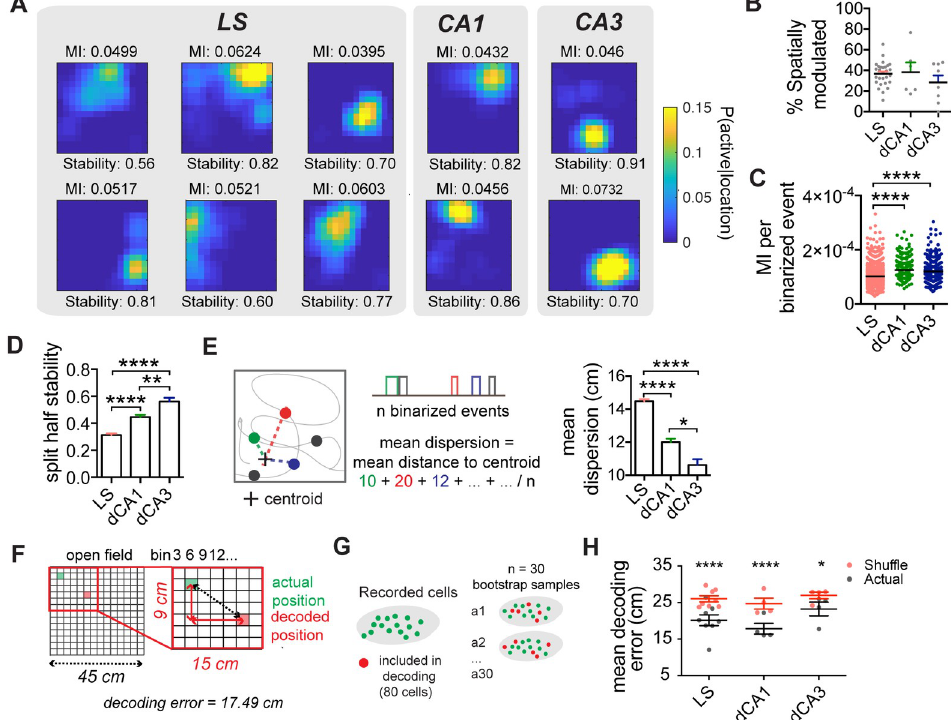
Fig 3. LS shares spatial coding characteristics with its main hippocampal inputs CA1 and CA3 during free exploration in a 2D environment. ( A) Example tuning maps of spatially modulated cells recorded from LS, dorsal CA1, and dorsal CA3 in a 45 × 45 cm open field (3 × 3 cm bins). (B) Proportion of spatial cells per animal (LS: n = 28 mice; dCA1: n = 6 mice; dCA3: n = 8 mice). (C) MI (bits) per binarized event for all cells recorded from each region (LS: n = 1,899 cells from n = 28 mice; dCA1: n = 1,031 cells, n = 6 mice; dCA3: n = 534 cells, n = 8 mice). (D) Within- session stability for spatial cells (LS: n = 734 spatial cells from n = 28 mice; dCA1: n = 424 spatial cells, n = 6 mice; dCA3: n = 138 spatial cells, n = 7 mice). (E) Left: mean dispersion computation. Right: mean dispersion for all spatial cells recorded from each region. (F) Method for computing the mean decoding error. (G) Bootstrapping approach using 80 randomly selected cells, for 30 bootstrapped samples. (H) Mean decoding error for LS ( n = 8 mice), CA1 ( n = 4 mice), and CA3 ( n = 4 mice). � 1, p < 0.05, �� , p < 0.01, ���� , p < 0.0001. Test used in B, one-way ANOVA, C–E, Kruskal– Wallis, Dunn’s multiple comparison test, H, two-way ANOVA, Sidak’s multiple comparisons test. The underlying data can be found in S1 Data. LS, lateral septum; MI, mutual information. Fig 3H). Similarly to recordings on the linear track, we used an activity cutoff of P(A) > 0.001 to confirm that the differences observed in decoding error between regions are not due to the inclusion of a large number of pseudo-silent cells in the bootstrapped sample (S13F Fig).